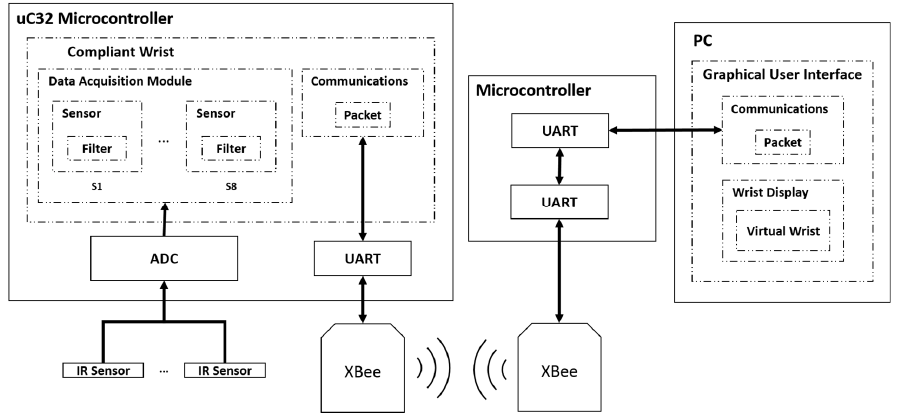
Figure 7. Compliant wrist sensing and communications system diagram.